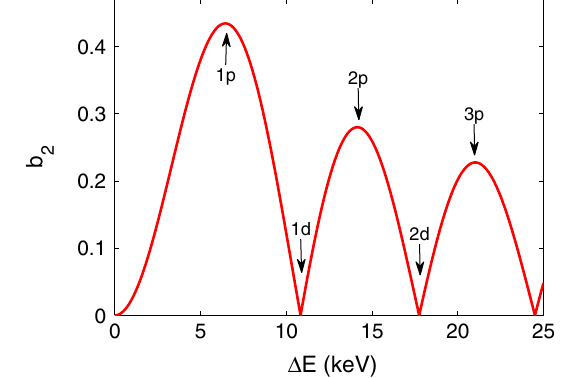
FIG. 7. Bunching at the 2nd harmonic of the 1590 nm laser for various energy modulations.